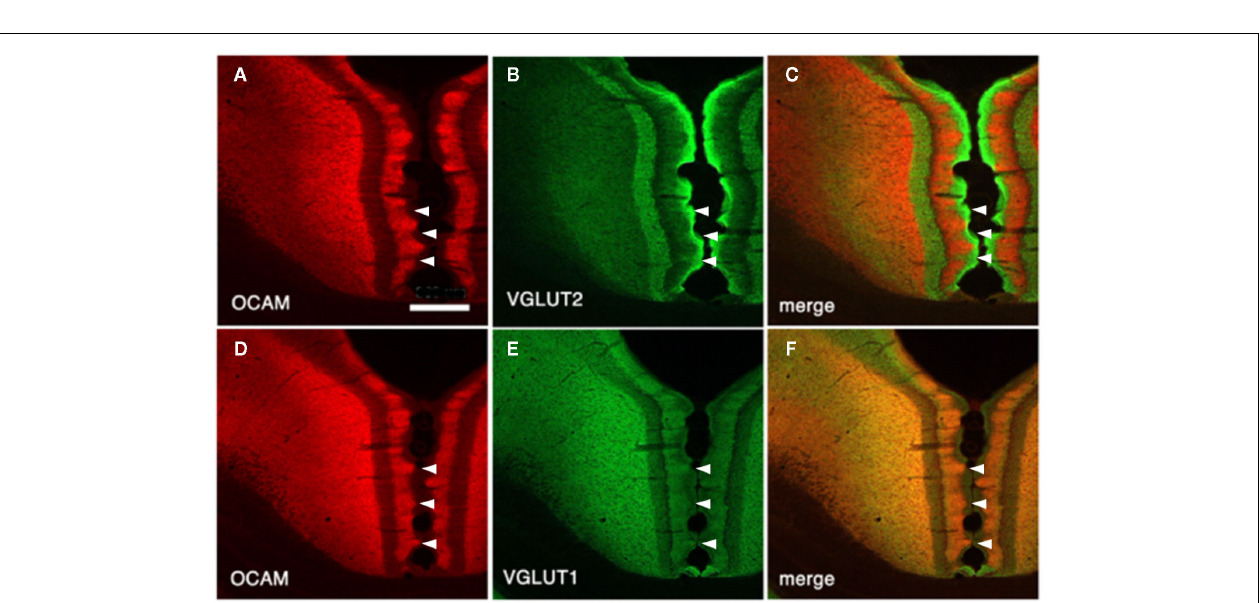
FIGURE 3 | Dendritic modules in layer 1 are visualized by OCAM-immunoreactive (ir) and MAP2-ir in adults. The right column shows merged images where patches of OCAM-ir and MAP2-ir are seen to